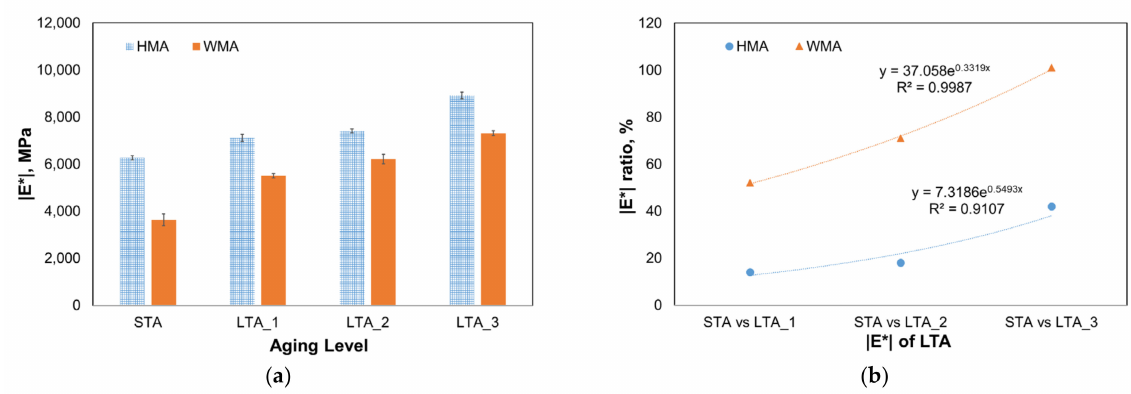
Figure 13. Dynamic modulus of the HMA/WMA mixtures for each stage of aging at 20 ◦ C (after moisture damage): ( a ) dynamic modulus and ( b ) rate of increase.